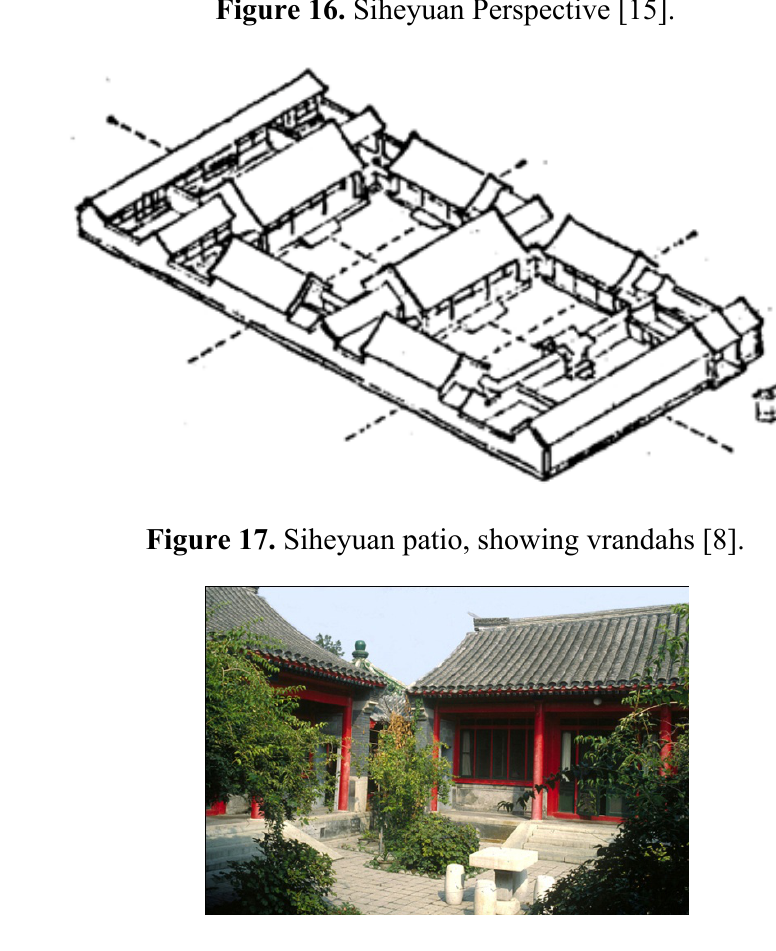
Figure 18. Siheyuan entrance, showing windows on wall